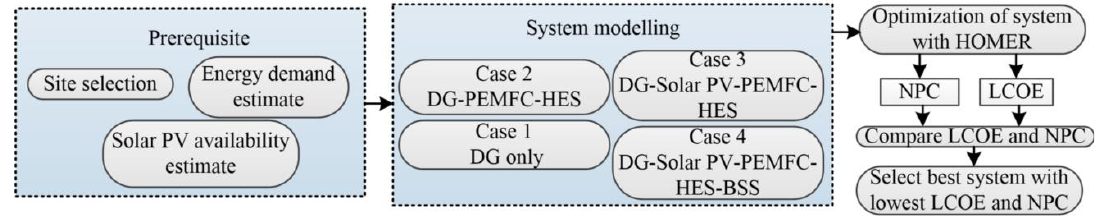
Figure 1. Flow chart for the proposed work.